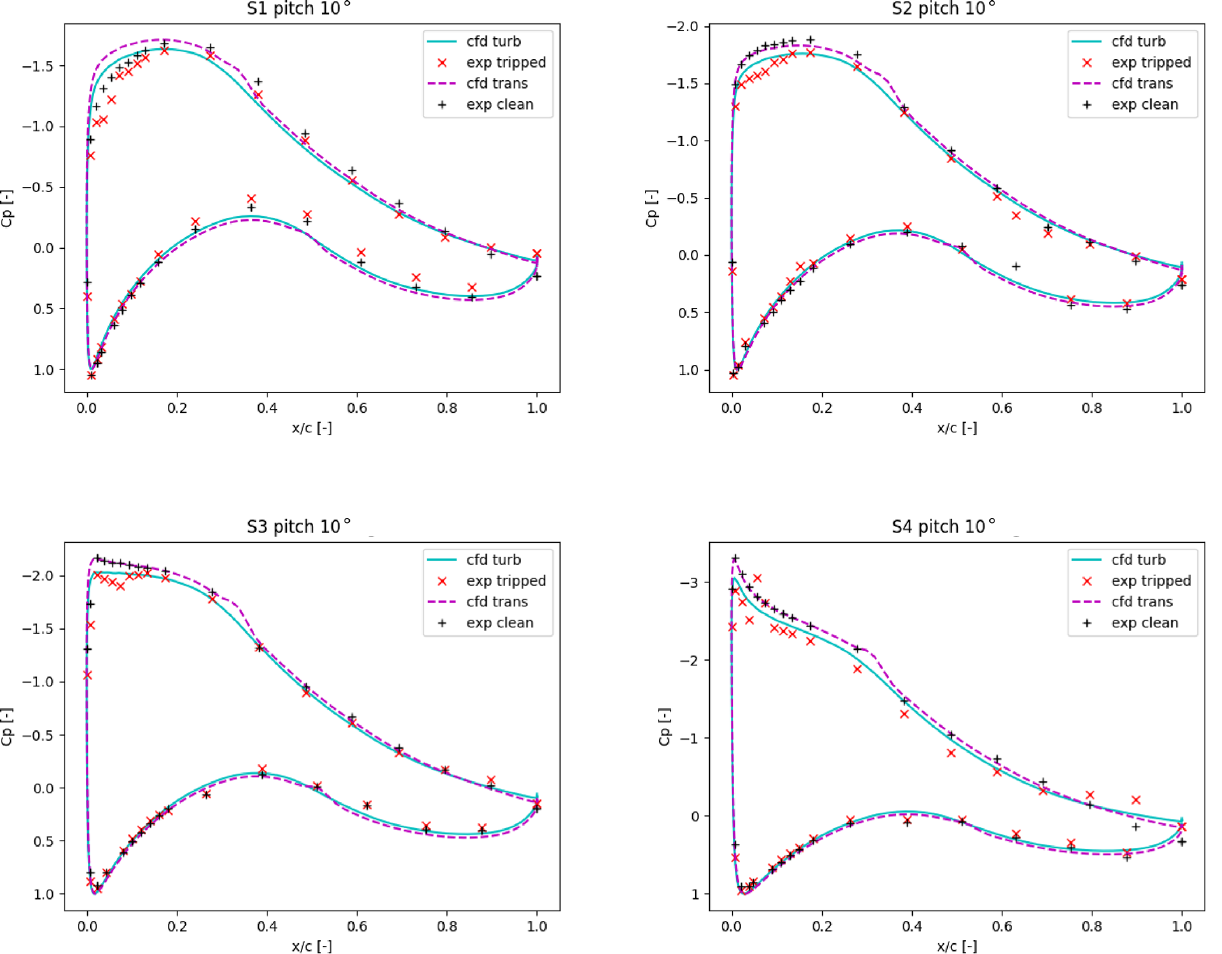
Figure 13. Pressure coefficient C p distribution, as a function of the normalized chordwise coordinate x/c . Each graph corresponds to a different section of the tip shape (see Fig. 5). EllipSys3D fully turbulent results (cfd turb) and with transition model (cfd trans). For the experimental tests, both clean configuration (exp clean) and tripped (exp tripped) are